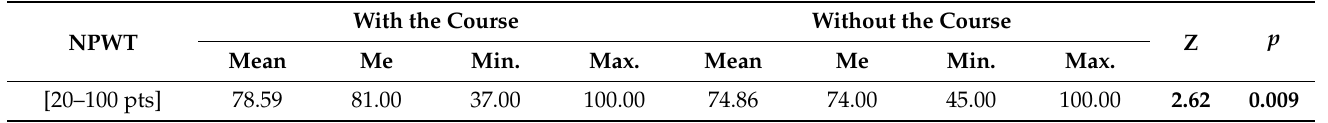
Table 9. Assessment of the relationship between general willingness to implement NPWT and completing a specialist course entitling to wound treatment. With the Course NPWT